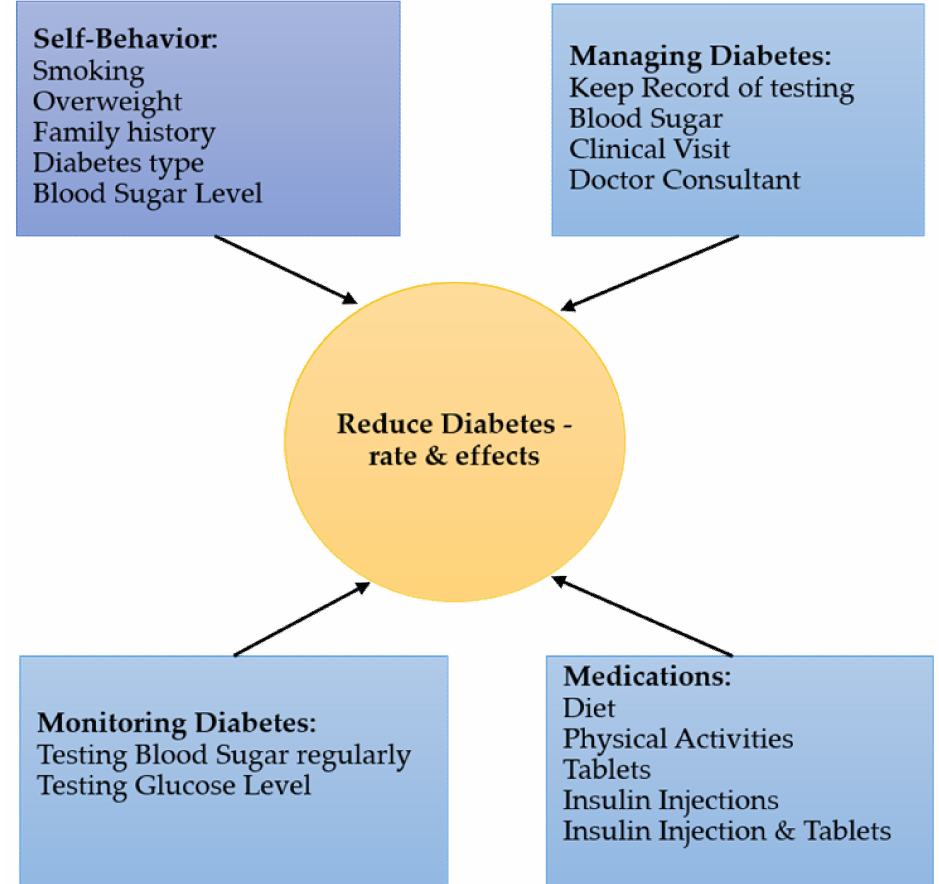
Figure 2. Theoretical